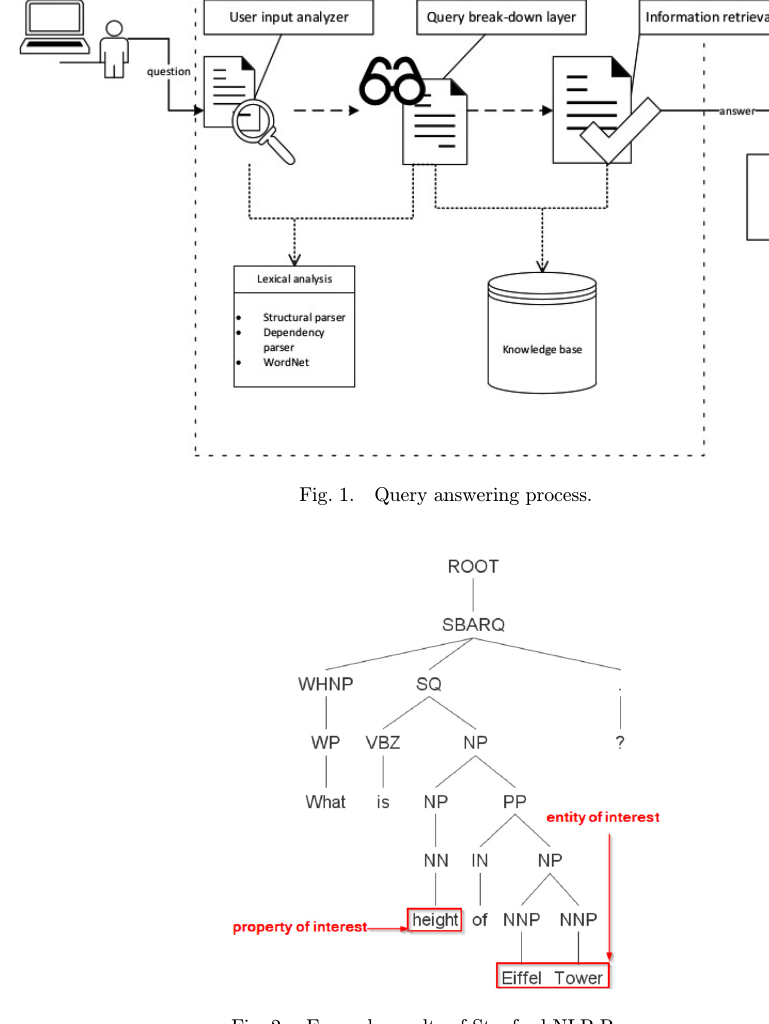
Fig. 2. Example results of Stanford NLP Parser.